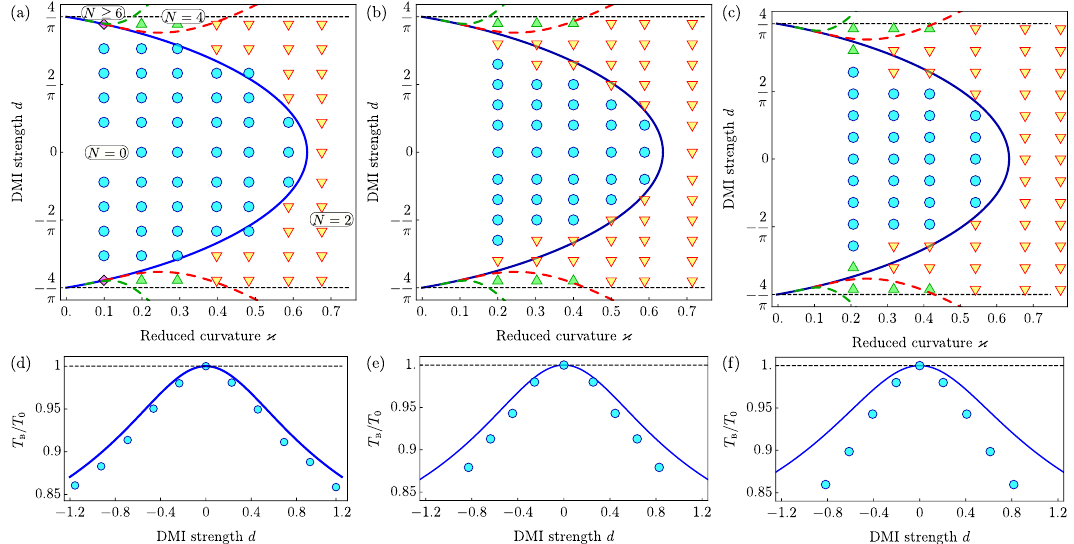
Figure 6: Phase diagrams of equilibrium states in nanotube with Bloch type DMI. (a), (b), and (c) are phase diagrams of equilibrium states in nanotube with Bloch type DMI: (a) and (d) FeGe epitaxial film with Q ≈ 26.3; (b) and (e) artificial material with Q = 2; (c) and (f) Pt / Co / AlOx layer structure with Q ≈ 1.71. In (a)-(c) symbols display the results of full-scale micromagnetic simulations: circles – normal (hedge- hog) magnetization distribution ( m = ± n ); other symbols – periodic states (purple diamond correspond to states with q ≥ 3). Blue solid line is analytical critical line determined by Eq. (8); dashed lines mark transitions between periodic equilibrium states with different number of DWs, as determined by numerical solution of ener- ( q ) = (cid:69) per ( q + 1 ) : q = 1 corresponds to red dashed line, q = 2 – gies equality (cid:69) per B B green. Dashed black horizontal lines correspond to critical DMI parameter in a flat = ± 4 /π . (d)-(e) are periods T / T = | cos ψ B | of mgnetization structure systems d 0 0 B in tube with (cid:99) ≈ 0.72, (cid:99) ≈ 0.71, and (cid:99) ≈ 0.78,